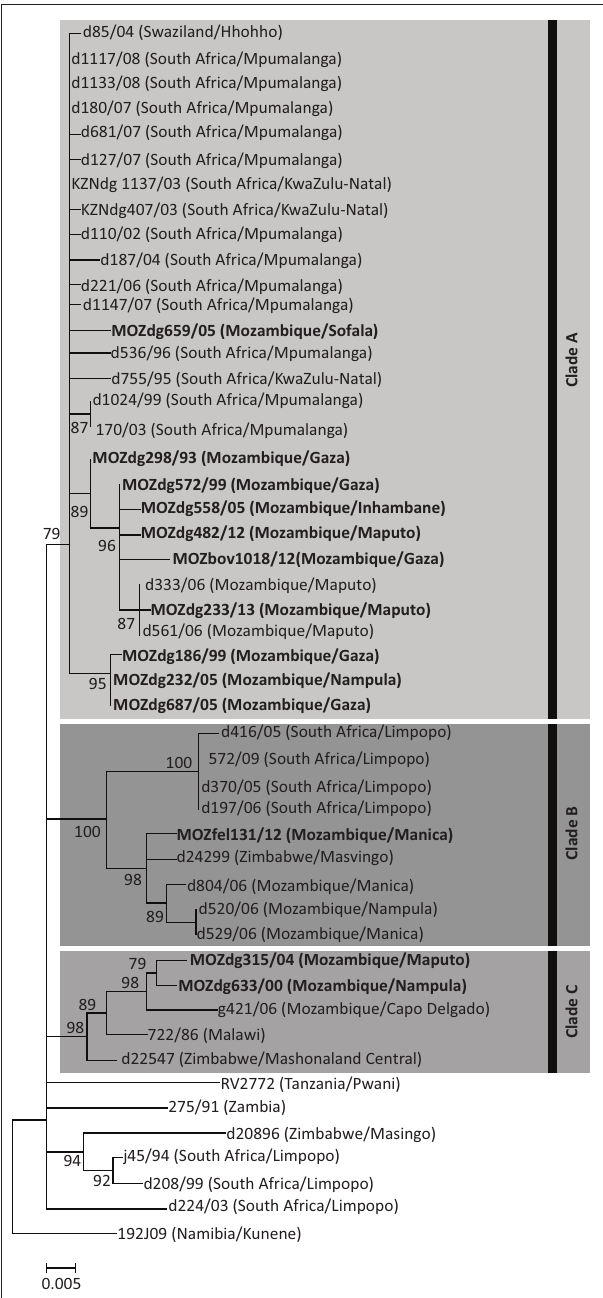
FIGURE 2: Maximum likelihood tree of 592 nucleotide (bases 4767–5358 according to the Challenge Virus Standard-11 rabies genome, GenBank accession number: GQ918139) sequences of the cytoplasmic domain of the G-L intergenic region for mammalian species (canine, feline, ovine, mongoose and domestic livestock) originating from selected sub-Saharan African countries. The horizontal branch lengths are proportional to the similarity of the sequences within and between groups and all branches with less than 75 bootstrap supports were collapsed. A Namibian jackal sequence (isolate 192J09) was used to root the